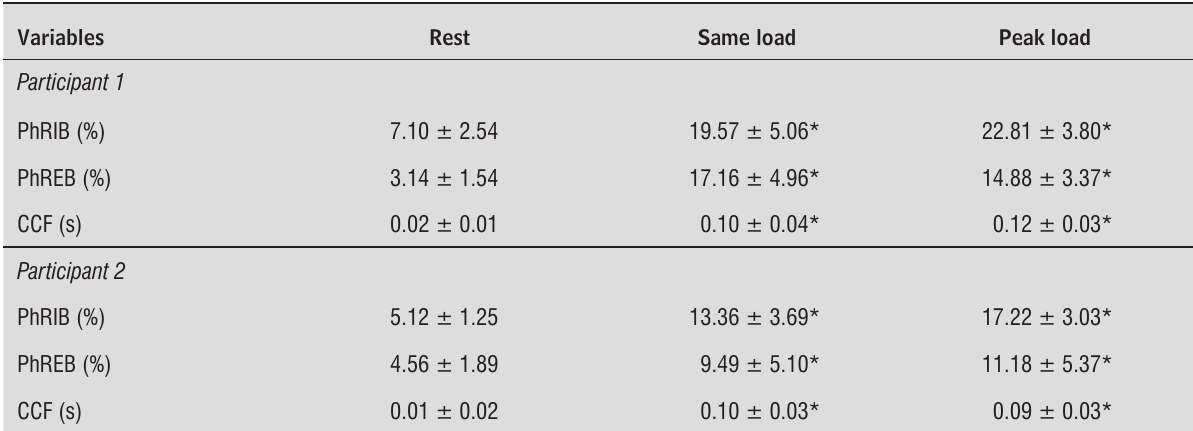
Table 2 - All tests mean of asynchronous TAM data at rest and during two exercise levels (same load and peak load) for both participants Variables Rest Same load Peak load